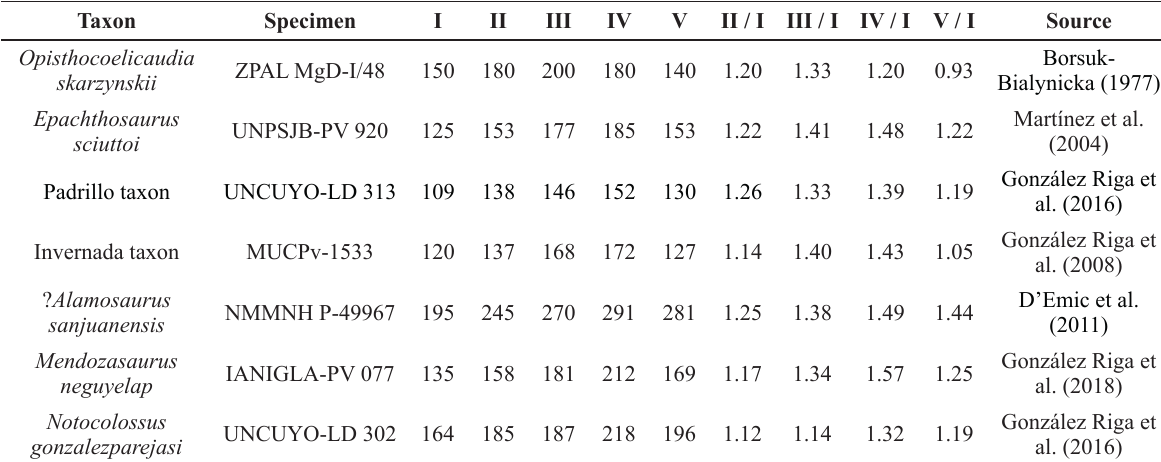
Proximodistal lengths and relative proportions of metatarsals of titanosaurian sauropods with the most completely preserved pedes. Roman numerals indicate metatarsal number. Columns I–V indicate lengths in mm; remaining columns are length ratios of various